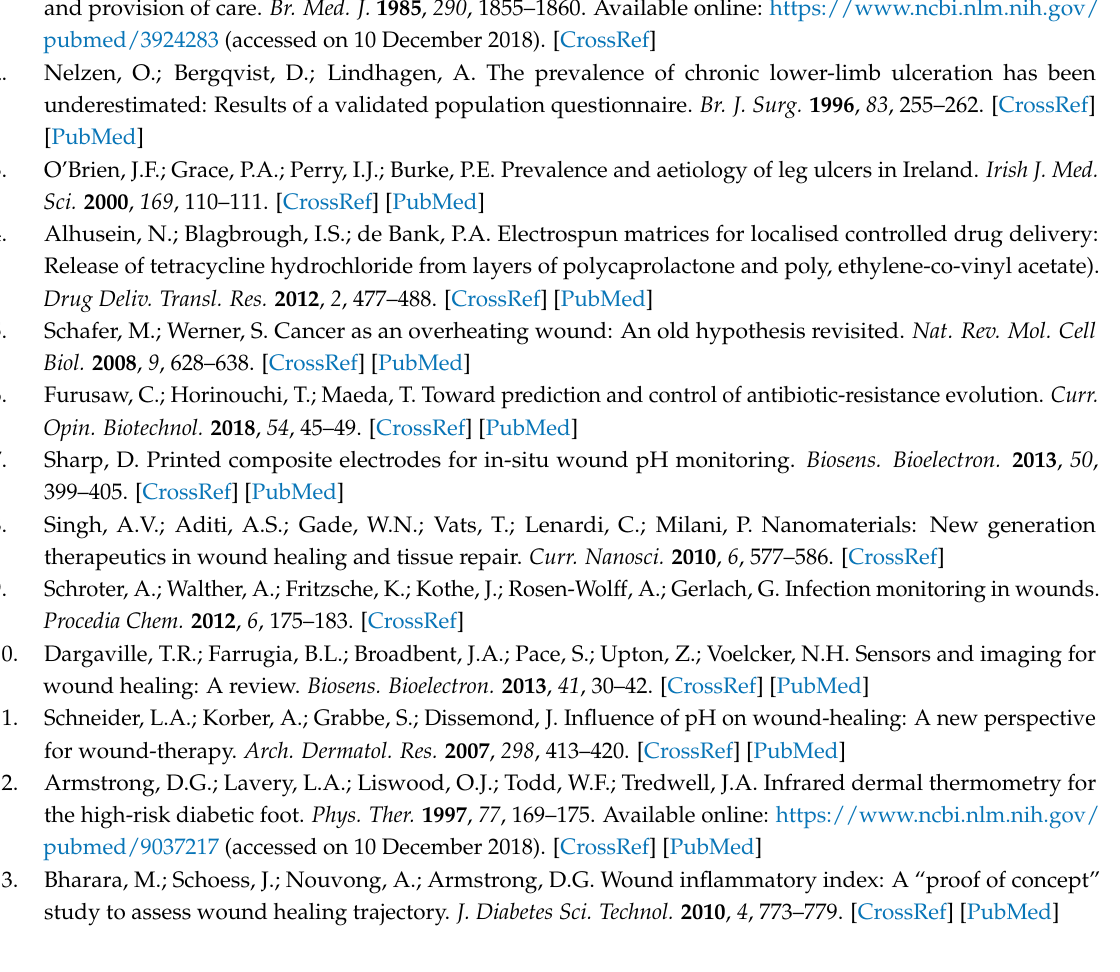
Figure S1: Photograph of FSES-based scalable manufacture of the electrospun double-layered nanofibrous membranes, Figure S2: The SEM morphology of FS electrospun PAA before crosslinking at magnification of 2000 × , Figure S3: The SEM morphology of FS electrospun PAA before crosslinking at magnification of 10,000 × , Figure S4: The SEM morphology of FS electrospun PAA after crosslinking at magnification of 5000 × , Figure S5: The SEM morphology of FS electrospun PAA after crosslinking at magnification of 10,000 × , Figure S6: The SEM morphology of FS electrospun PMMA-co-MAA at magnification of 500 × , Figure S7: The SEM morphology of FS electrospun PMMA-co-MAA at magnification of 10,000 × , Figure S8: The response of BTB when immersed in different pH buffer solutions, Figure S9: The response of the hybrid nanofibrous membrane PAA*(PMMA-co-MAA)10 to the increase of pH values at different buffer solutions, immediately after soaking, Figure S10: The response of the hybrid nanofibrous membrane PAA*(PMMA-co-MAA)10 to the increase of pH values at different buffer solutions after two-hour